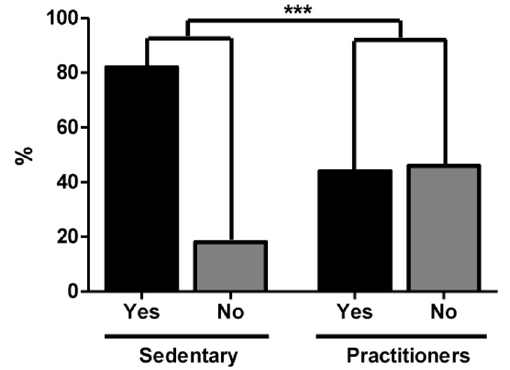
Figure 1 - Percentage distribution of dysmenorrhoea